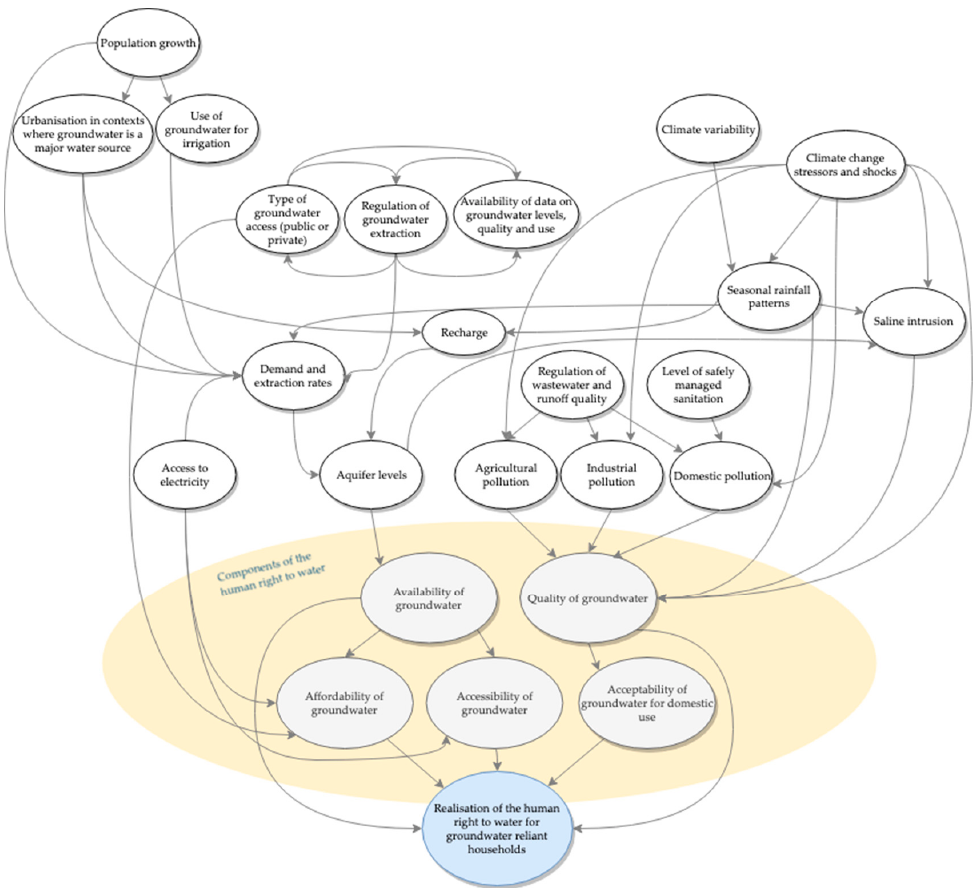
Figure 3. Influence diagram exploring how resource dynamics affect components of the human right to water for groundwater-reliant households. Arrows should be read as ‘influences’, rather than implying causation. Note that important factors shaping groundwater resources and their access, such as soil type and geology, are held constant, and therefore, not included in the diagram.